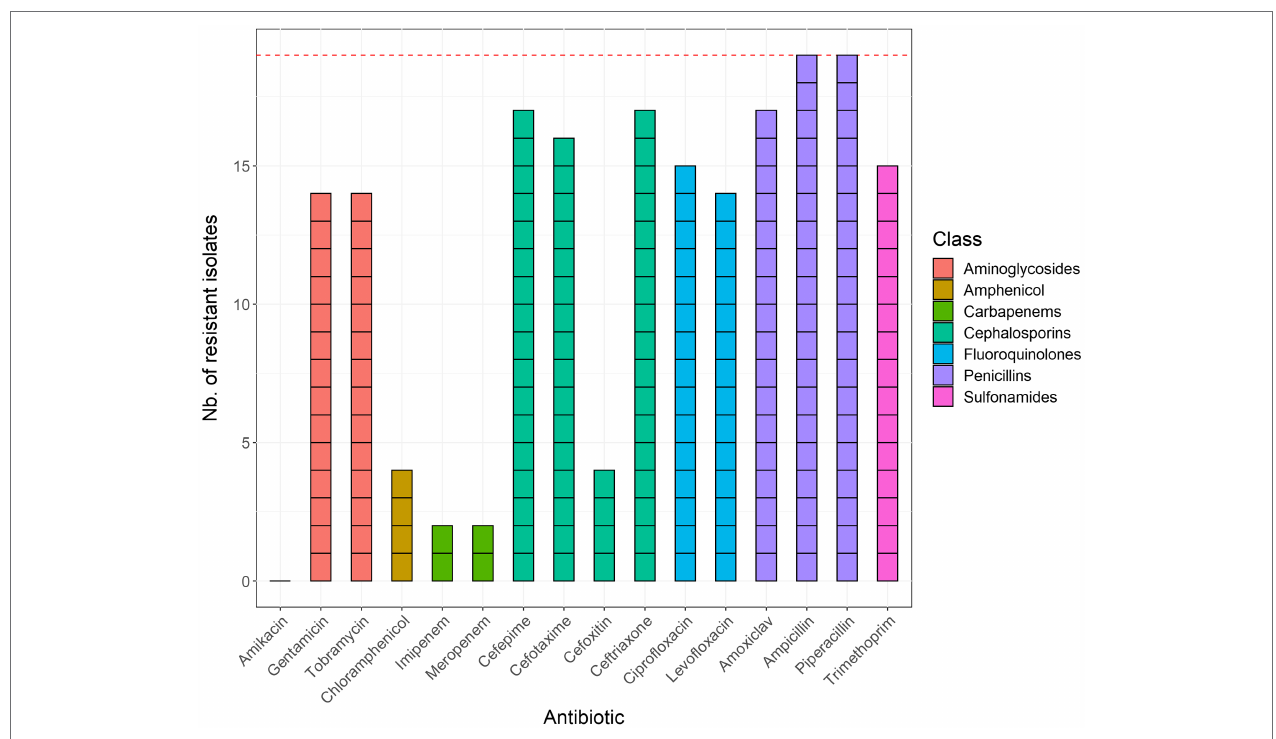
FIGURE 1 | Results of phenotypic antimicrobial susceptibility testing of the 19 sequenced E. coli isolates. Bars are colored according to the corresponding class of antibiotics. The red horizontal line corresponds to the total number of isolates ( n = 19). Trimethoprim + sulfamethoxazole was abbreviated to trimethoprim and amoxicillin + clavulanic acid to